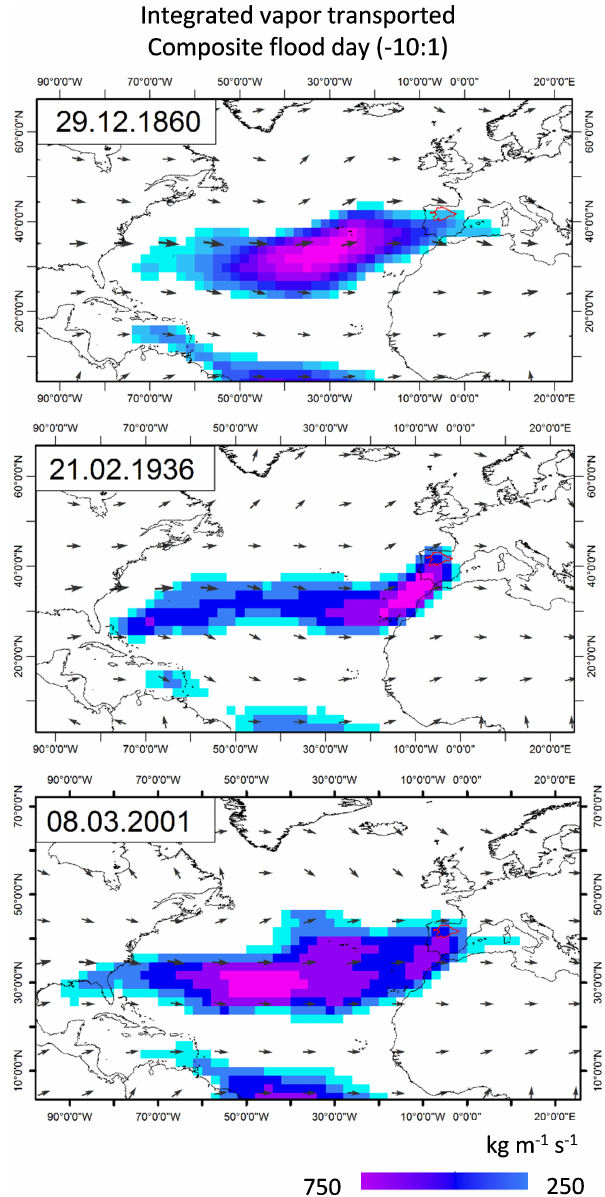
Figure 10. Integrated water vapour transported averaged on the